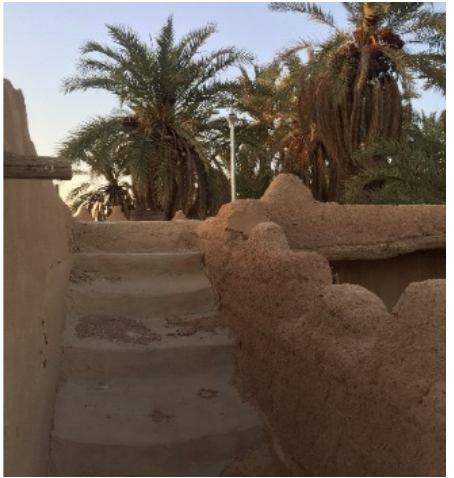
Figure 10. Long palm tree shaded the traditional house in Hail city.